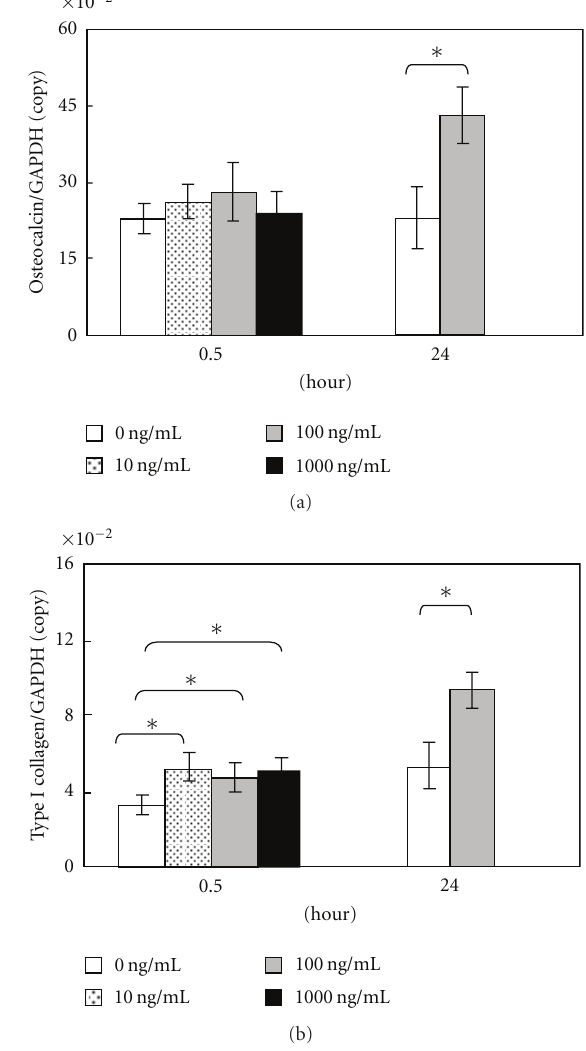
Figure 4: Graph of osteocalcin (a) and type I collagen (b) copy number determined using LightCycler. Data represent means ± SD in five samples in three separate experiments. Significantly di ff erent from control values ( ∗ P < 0 .